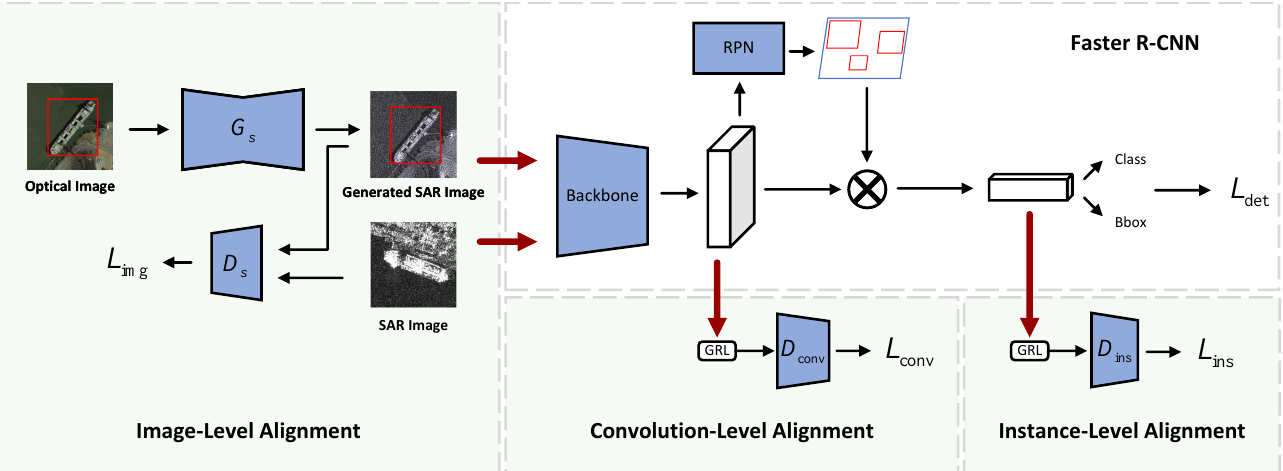
Figure 3. The overall framework of the proposed MAN. MAN reduces the domain shift on different levels: image-level, convolution-level, and instance-level. First, image-level alignment exploits generative adversarial networks to generate SAR images from the optical images. Then, the generated SAR images and the real SAR images are used to train the detector. To further minimize domain distribution shift, the detector integrates convolution-level alignment and instance-level alignment. Convolution-level alignment trains the domain classifier on each activation of the convolutional feature, which minimizes the domain distance to learn domain-invariant features. Instance-level alignment reduces domain distribution shift on the features extracted from the region